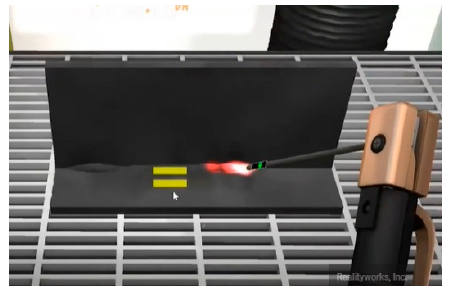
Figure 11. VR Welding Simulation Screen.